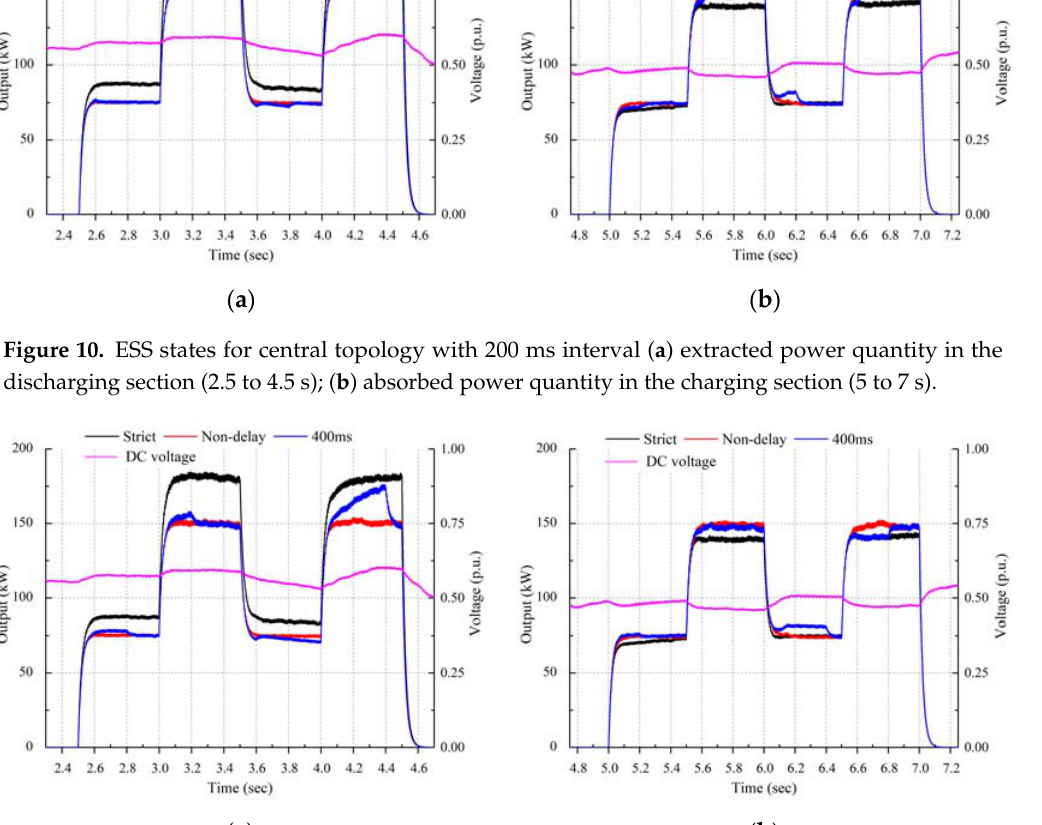
Figure 11. ESS states for central topology with 400 ms interval ( a ) extracted power quantity in the discharging section (2.5 to 4.5 s); ( b ) absorbed power quantity in the charging section (5 to 7 s).